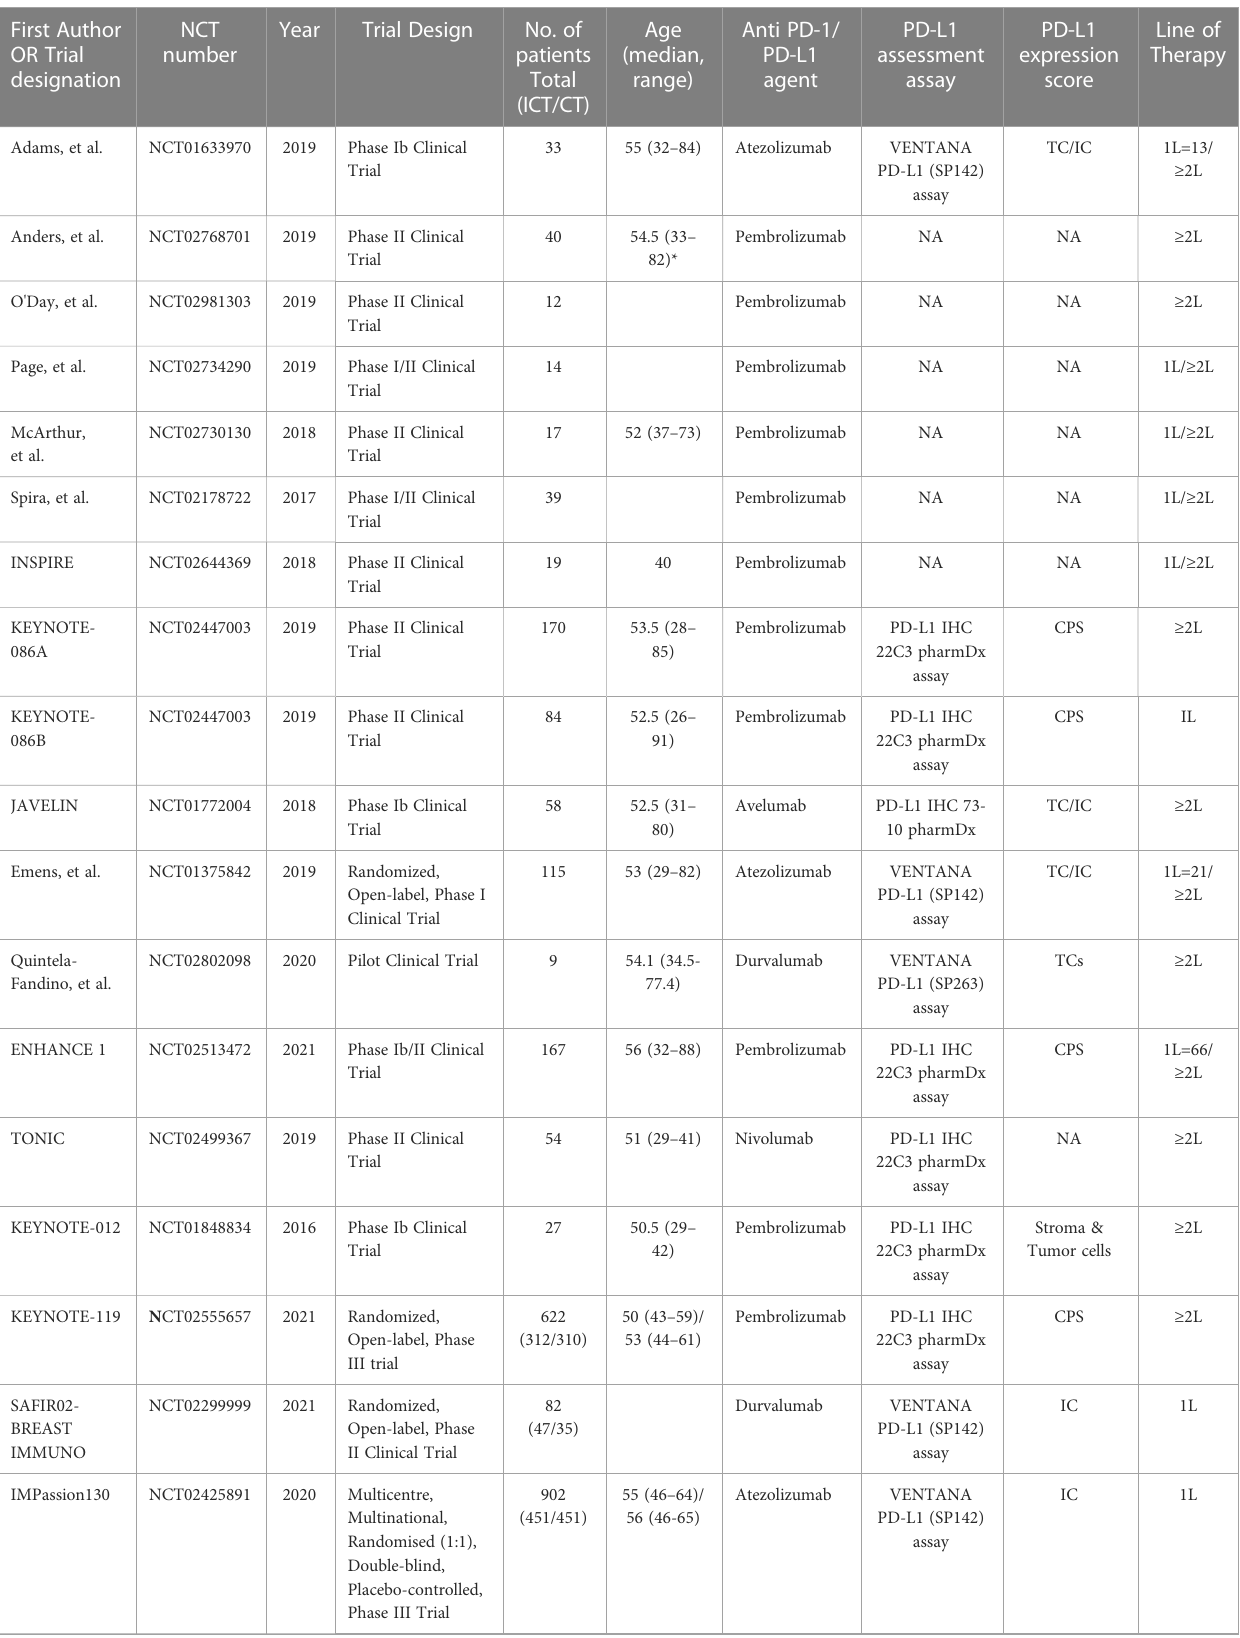
TABLE 1 General characteristics of the included randomized controlled